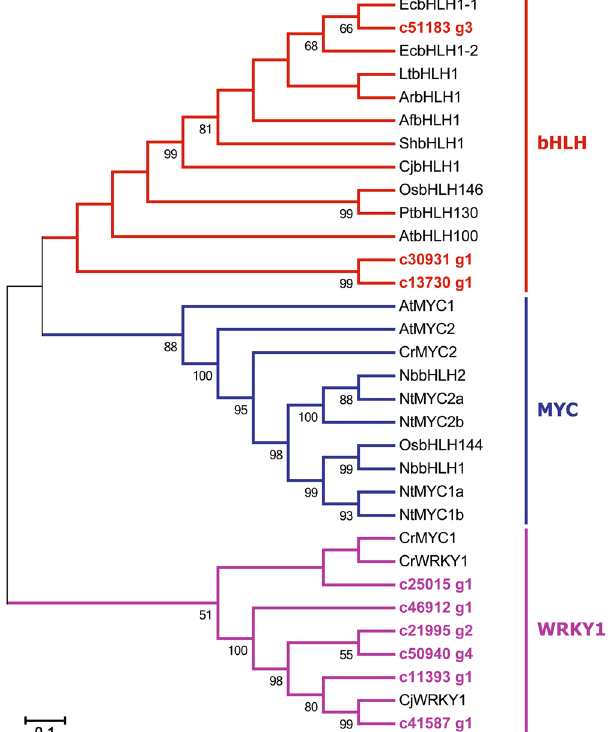
Figure 7. Phylogenetic analysis of TFs. Phylogenetic tree was constructed based on the deduced amino acid sequences for D . scandens TFs (bold letters) and other plant TFs involved in IQA biosynthesis. Accession Nos. are: Q39204, AtMYC2; Q8W2F1, AtMYC1; Q9ZVB5, AtbHLH100; AAQ14331, Catharanthus roseus CrMYC1; AAQ14332, CrMYC2; GQ859152, OsbHLH144; BAF14724, OsbHLH146; EEC73367, poplar